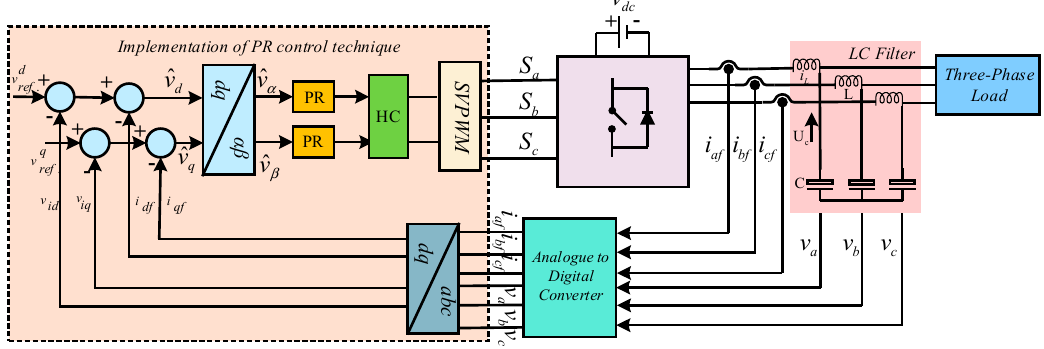
Figure 21. General schematic of a PR Controller and HC for a three-phase VSI.